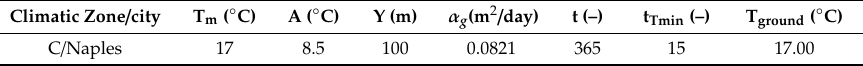
Table 3. Temperature of the soil T g obtained by Kusuda equation for